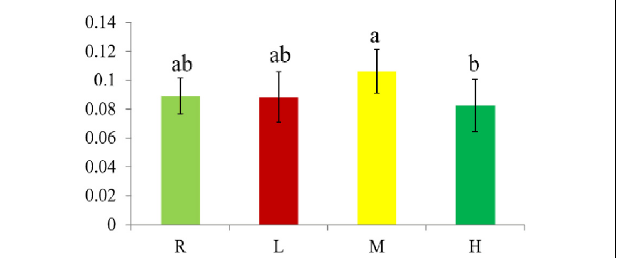
FIGURE 1 | The Spleen index of hybrid grouper fed diets containing different oxidized fish oil level. Diverse little letters above histogram bars indicate significant differences ( P < 0.05) in different dosage groups in Duncan’s multiple range tests, n =